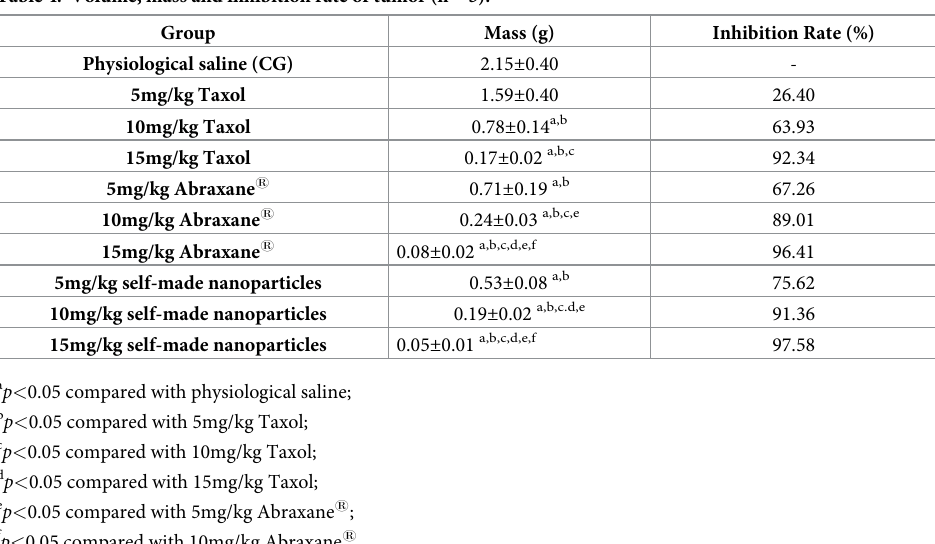
Table 4. Volume, mass and inhibition rate of tumor (n =